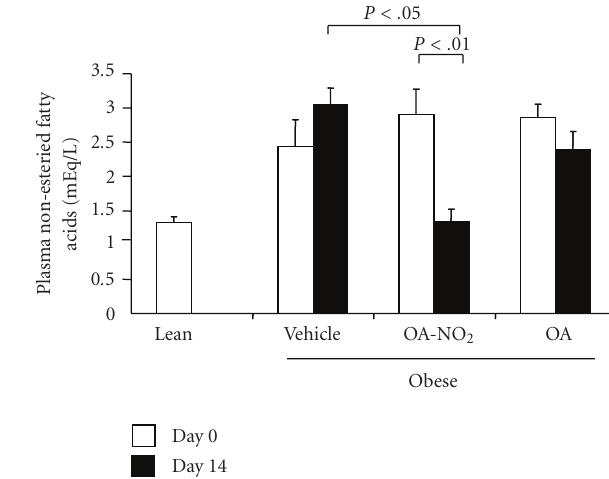
Figure 6: Plasma non-esteried fatty acids in obese Zucker rats before and after 14-d infusion with vehicle, OA-NO 2 , or OA. Lean rats with vehicle treatment were used as controls. Lean: n = 3; Vehicle: n = 7; OA-NO 2 : n = 5; OA: n = 5. Data are mean ± SE.